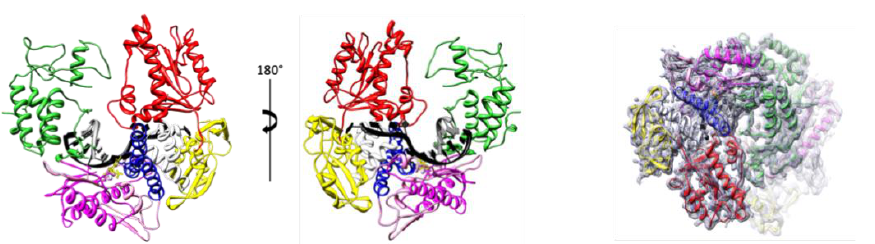
Figure 2. TgoT_6G12 polymerase structure in binary and ternary complexes. Overall structure of TgoT_6G12 in binary ( A ) and ternary complex ( B ). On the left, front and back views of the polymerase are colored by domain. The primer and template DNA strands are colored in grey and black, respectively. The domains are labeled as follows: N-terminal domain (yellow), 3’-5’ exonuclease domain (red), palm domain (light and dark magenta represent the N-terminal and the C-terminal respectively), fingers domain (blue) and thumb domain (green). An interhelical segment between the exonuclease and the palm domain is colored in light grey. On the right, the 2Fo–Fc electron density omit map is shown and contoured at a level of 1 σ to illustrate which domains are less ordered than the others. A rotation of 180 ◦ around a horizontal axis was applied between the middle panel and the right-hand panel.